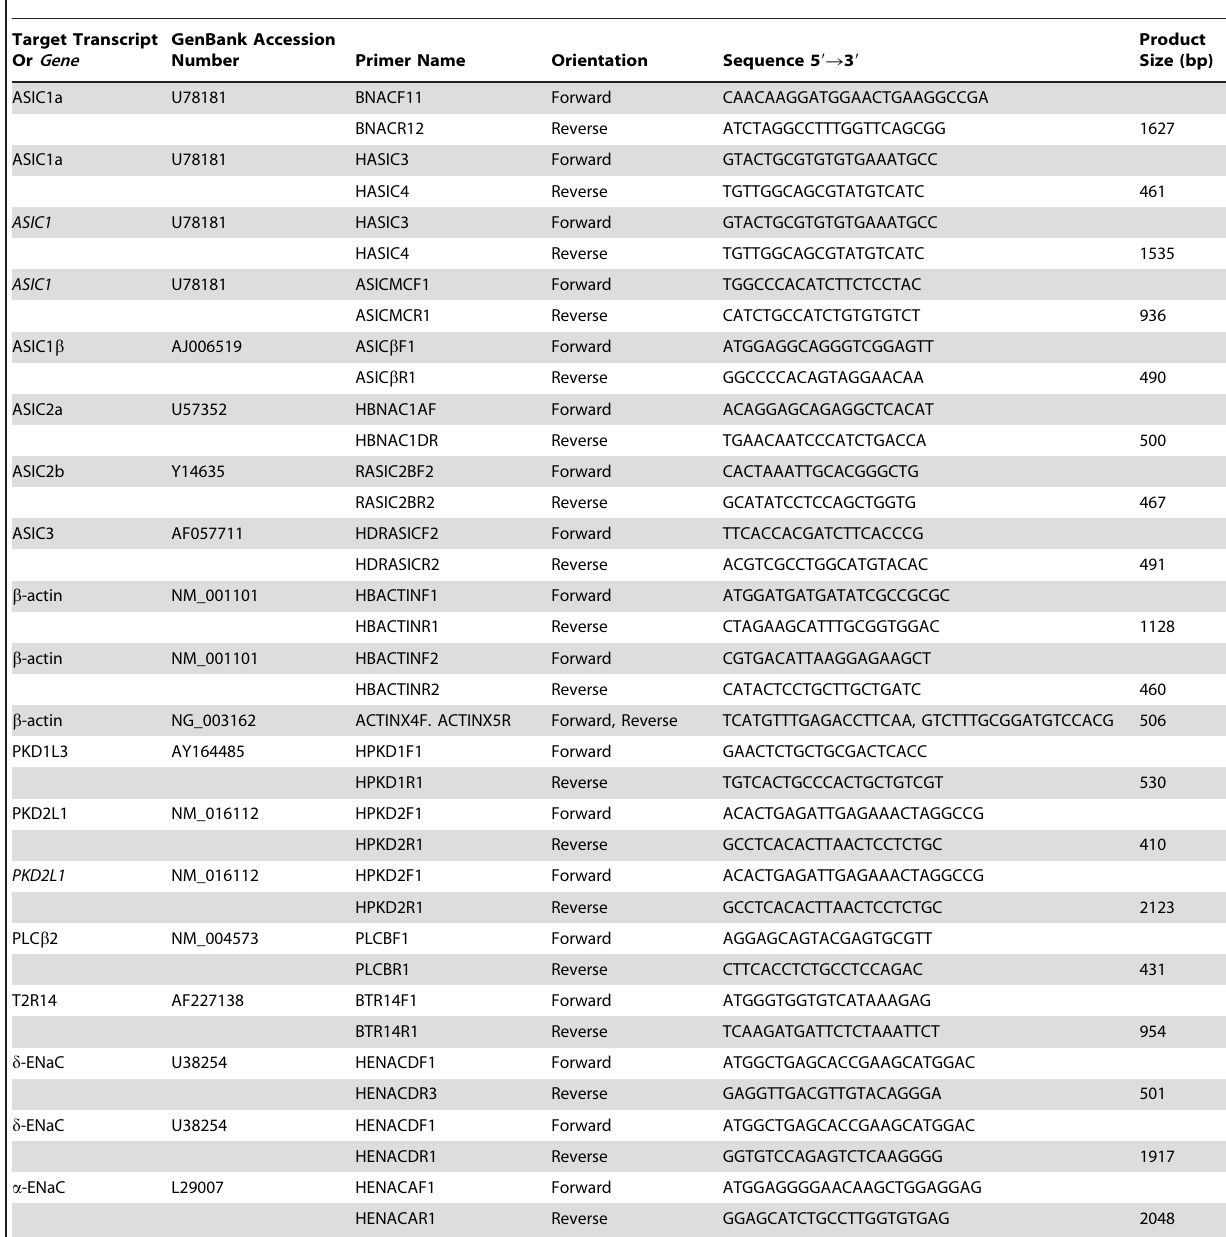
Table 1. List of primers used in this